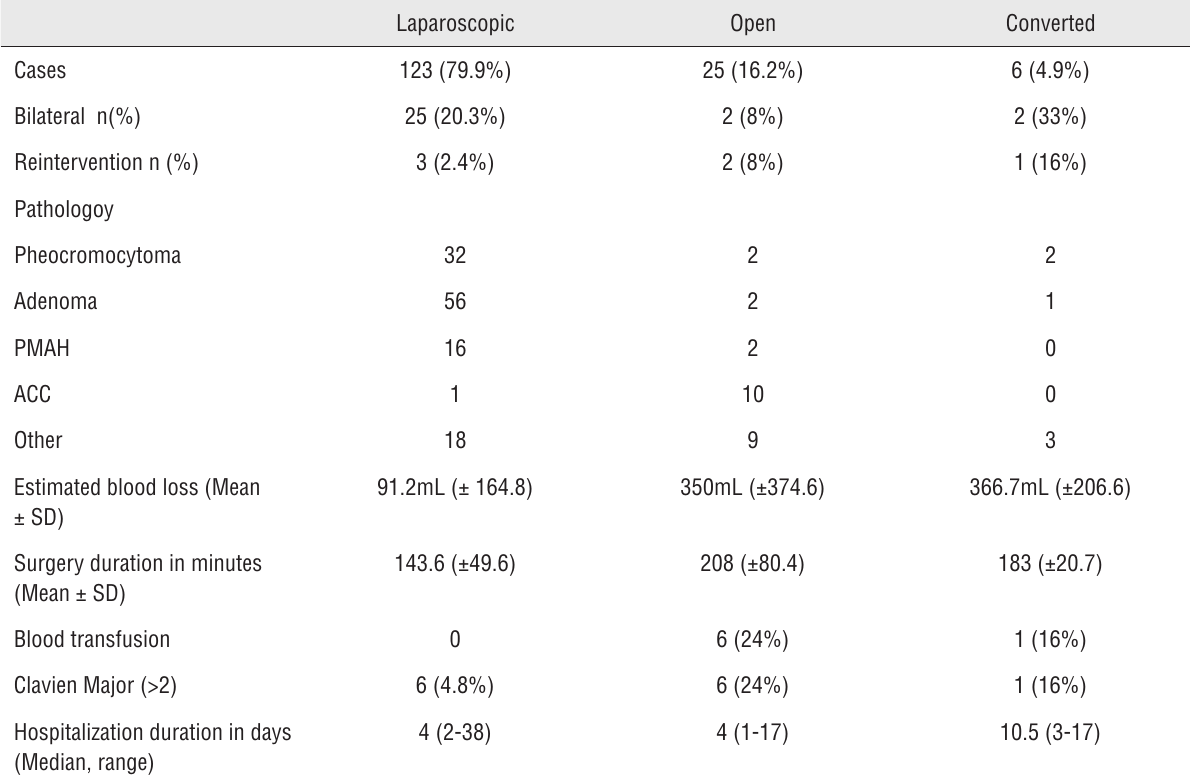
Table 7 - Results stratified by laparoscopic, open and converted surgery. Laparoscopic